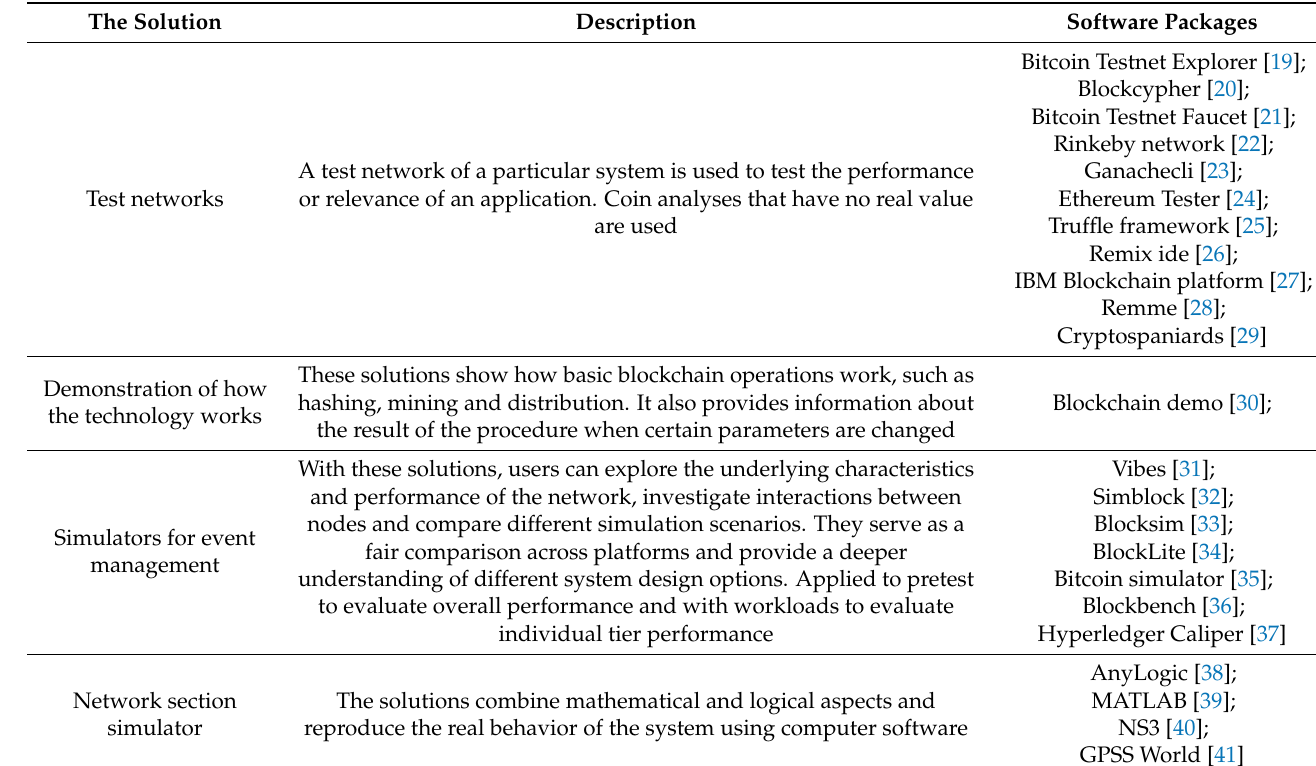
Table 2. Simulation solutions for blockchain